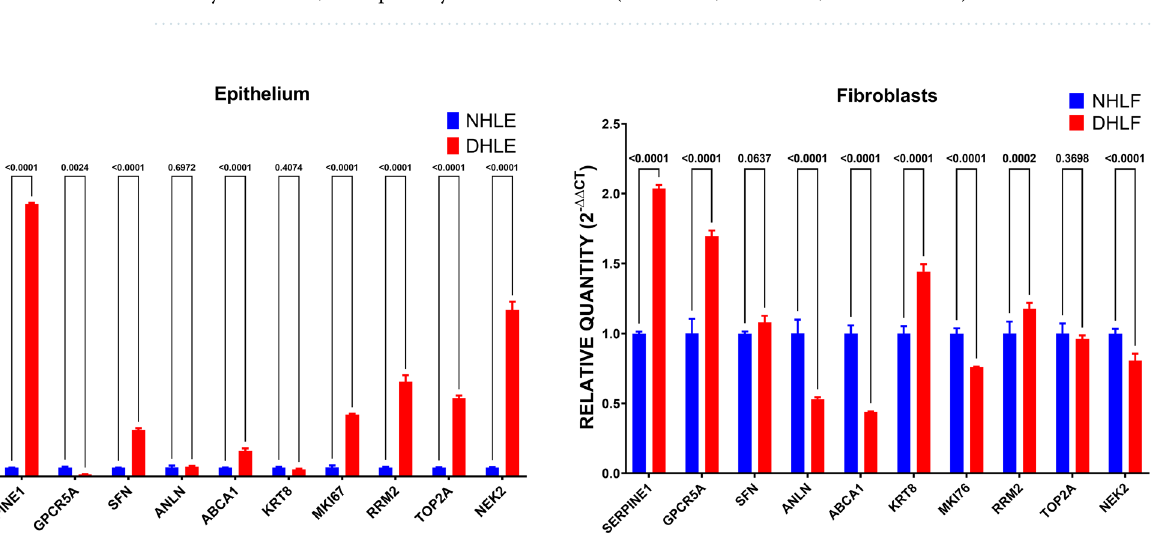
Table 1. List of genes related to cell cycle displayed significant differential expression between asthmatic and healthy epithelium in both genders, bronchial brush versus the biopsy sample, and between asthmatic and healthy fibroblasts, from publicly available datasets (GSE64913, GSE76227, and GSE27335).